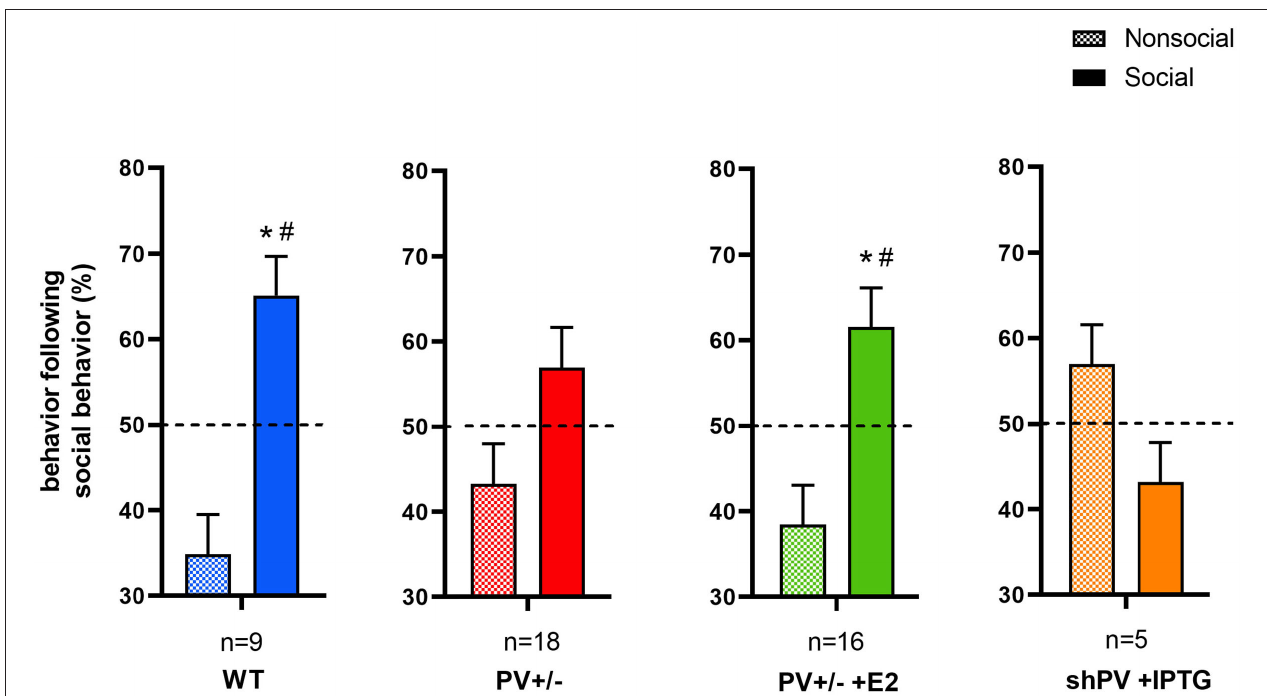
FIGURE 3 | In the reciprocal interaction assay, the type and duration of each behavior is recorded, yielding ethograms for mouse pairs ( Figure 1 in Wöhr et al., 2015). Behaviors classified as social include 1) facial and anogenital sniffing, 2) following, 3) social grooming, 4) pushing past, 5) crawling over-/under and 6) social inactive. Non-social behaviors include rearing, digging, and grooming. After each social-type interaction (independent of its duration) occurring during a 5min observation period, the next interaction is either classified as social or non-social. From these data, the percentages of social and non-social interactions following a social interaction are calculated. In WT (blue bars) and E2-treated rescue PV + / − (green bars) mouse pairs, a social interaction is likely followed by another social interaction. This preference is not observed in constitutive PV + / − (red bars) or shPV mice, where parvalbumin (PV) is downregulated from PND18 to PND24 (orange bars); all mice were tested at PND25. It should be noted that the numbers shown (n) represent mouse pairs (i.e., the actual number of mice tested is 2n). Data for the first three groups are taken from Filice et al. (2018). Data for shPV mice is original. All other experimental details on breeding, testing, and data analysis can be found in Filice et al. (2018) and Wöhr et al. (2015) and briefly in Supplementary Materials . The dashed line indicates the 50% chance level. Filled and checkered bars represent social and non-social behaviors, respectively. * p < 0.05 vs. non-social; # p < 0.05 vs. 50% chance